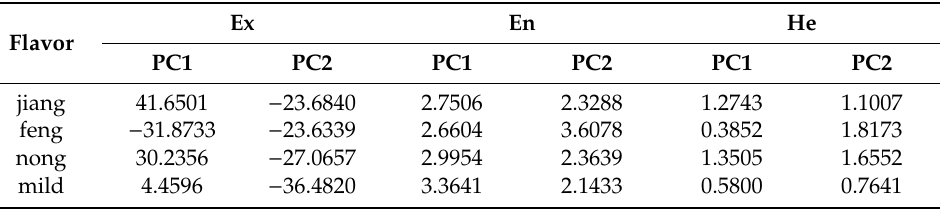
Table 3. Characteristic values of di ff erent flavor